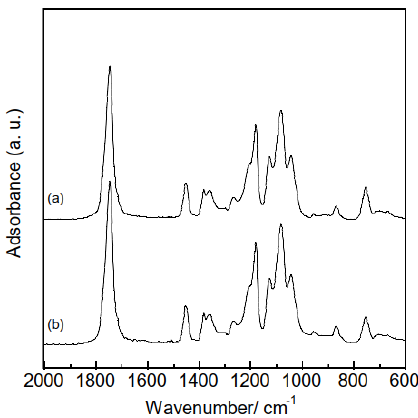
Figure 4. ATR-FT-IR spectra of the ( a ) polymer and ( b ) composite samples.